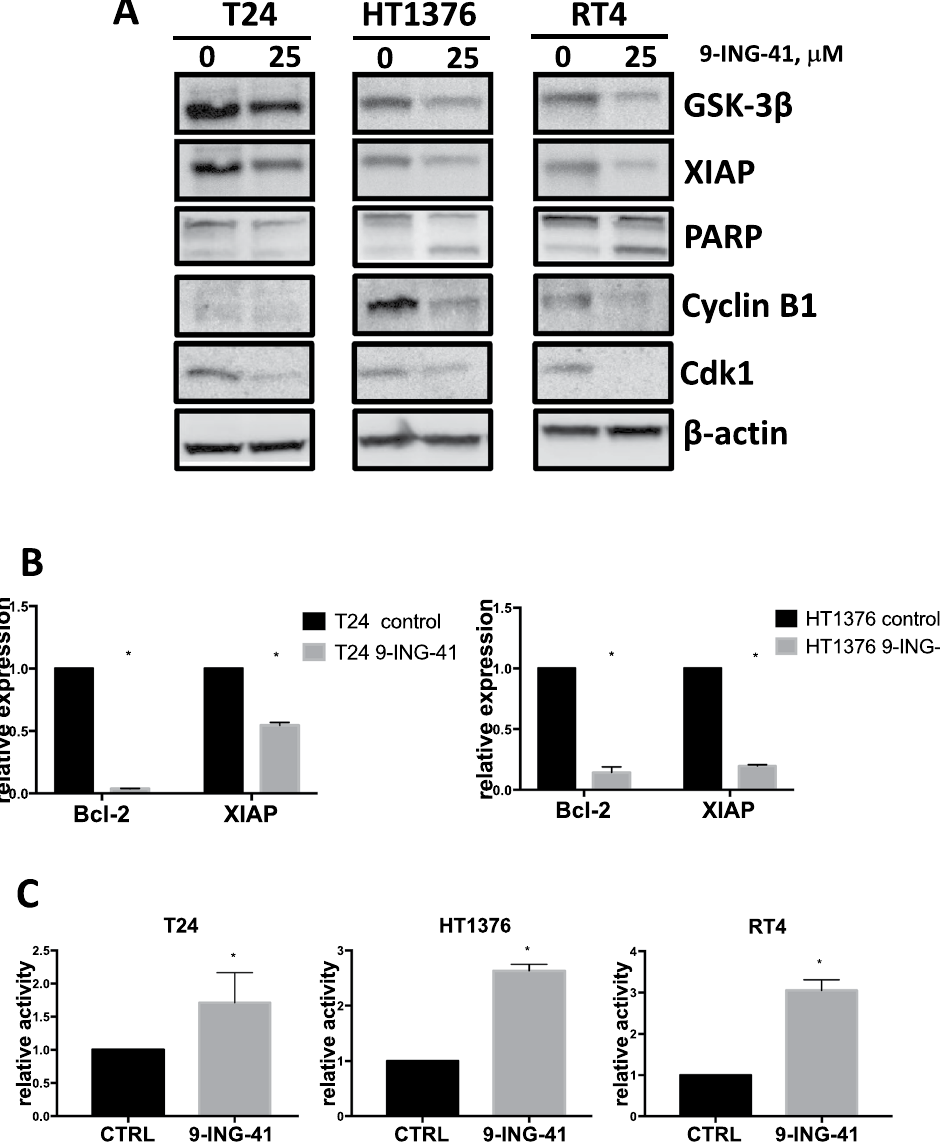
Figure 2. Antitumor effects of 9-ING-41 therapy in bladder cancer cells. ( A ) Bladder cancer cells were treated with indicated concentration of 9-ING-41 for 96 hrs. Post-treatment, whole cell lysate was prepared from the cells, separated by SDS-PAGE (20 μ g/well), transferred to PVDF membrane, and immunoblotted as indicated. ( B ) T24 and HT1376 bladder cancer cells were treated with 9-ING-41 for 72 hours and mRNA expression of Bcl-2 and XIAP was analyzed by RT-PCR. Columns, mean; bars, SD. * P < 0.05 by one-way ANOVA with Tukey post-hoc test. ( C ) Activity of caspase-3 was detected in 9-ING-41-treated bladder cancer cells using colorimetric CaspACE Assay System. Columns, mean; bars, SD. * P < 0.05 by one-way ANOVA with Tukey post-hoc